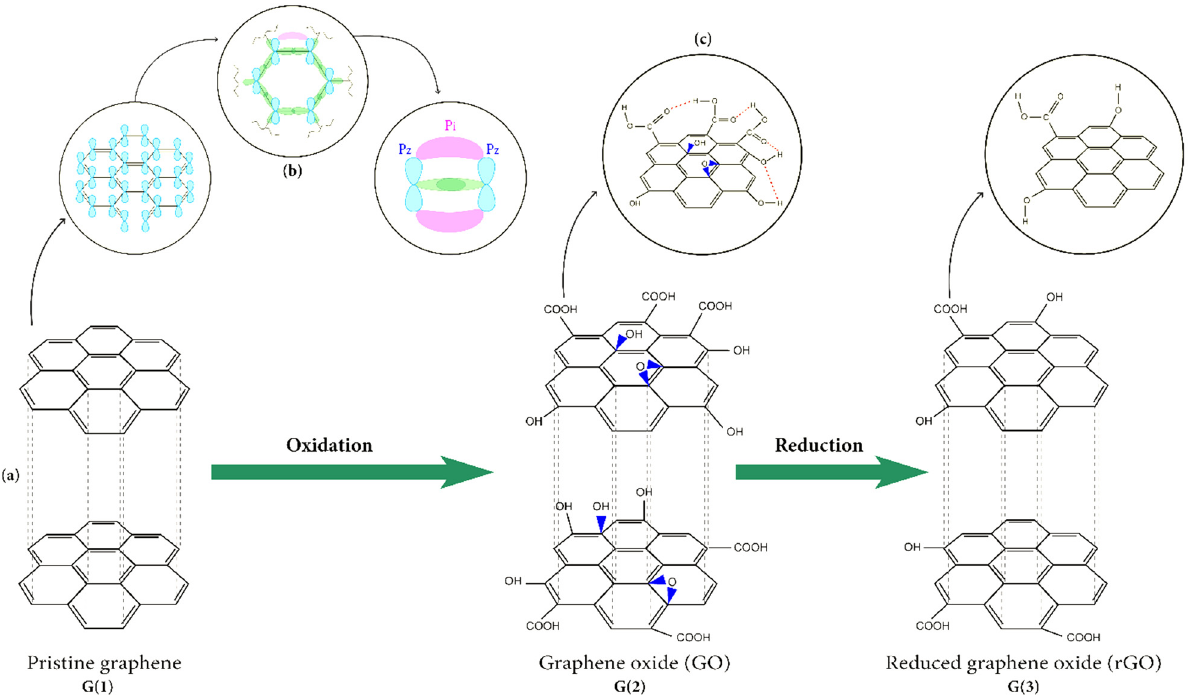
Figure 2: G ( 1 ) Pristine graphene: ( a ) displays van der Waals bonds between two graphene sheets and ( b ) displays sp 2 carbon atom orbitals. G ( 2 ) GO: ( c ) displays intramolecular bonds between single layers of GO and red dashes are representative of intramolecular hydrogen bonds, G ( 3 )